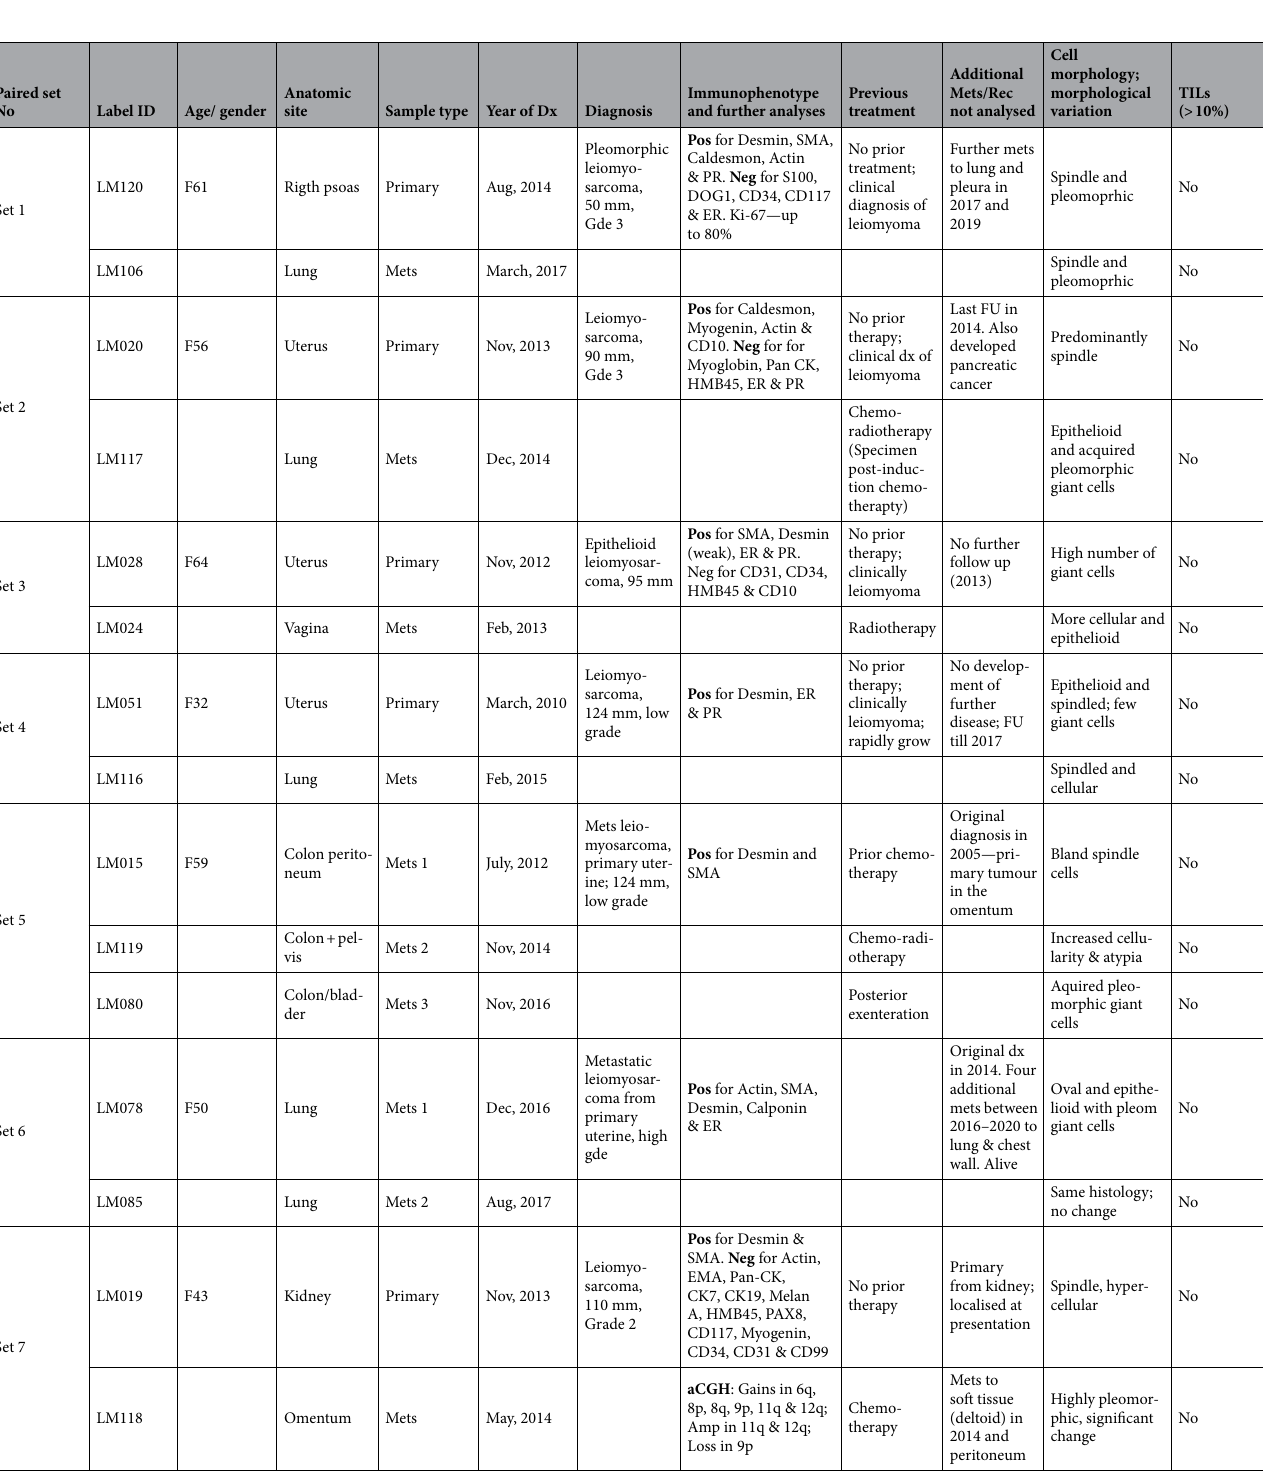
Table 1. Clinical and pathological features of matched leiomyosarcoma samples. Mets: Metastasis; Gde: Grade (FNCLCC system); Pos: Positive; Neg: Negative; SMA: Smooth Muscle Actin; PR; Progesterone Receptor, ER: Estrogen Receptor; TILs: Tumour-infiltrating lymphocytes; Dx: diagnosis; FU: Follow-up; aCGH: array comparative genomic hybridization; Amp: Amplification; FISH: Fluorescent in-situ hybridization (break-apart